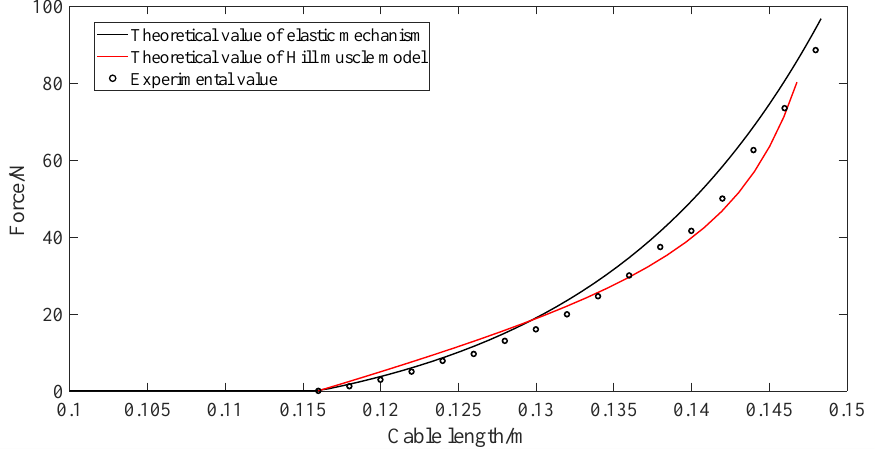
Figure 13. Passive elastic characteristic experiment.